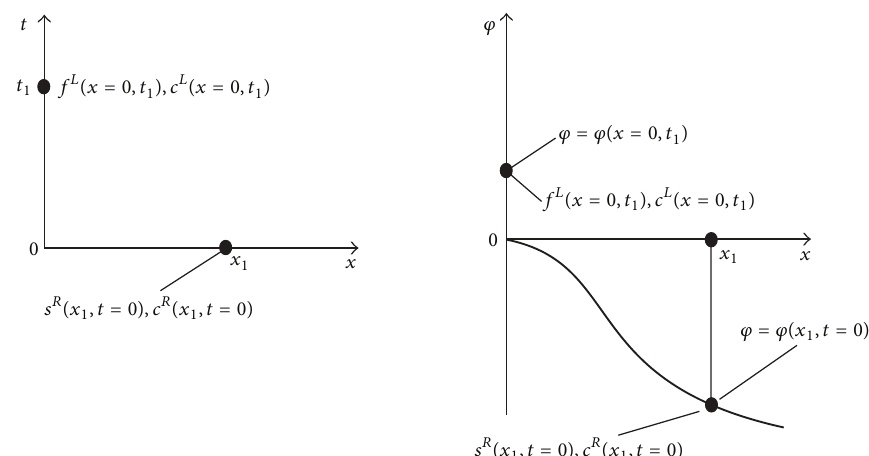
Figure 2: Introduction of potential function (Lagrangian coordinate) and mapping between independent variables.